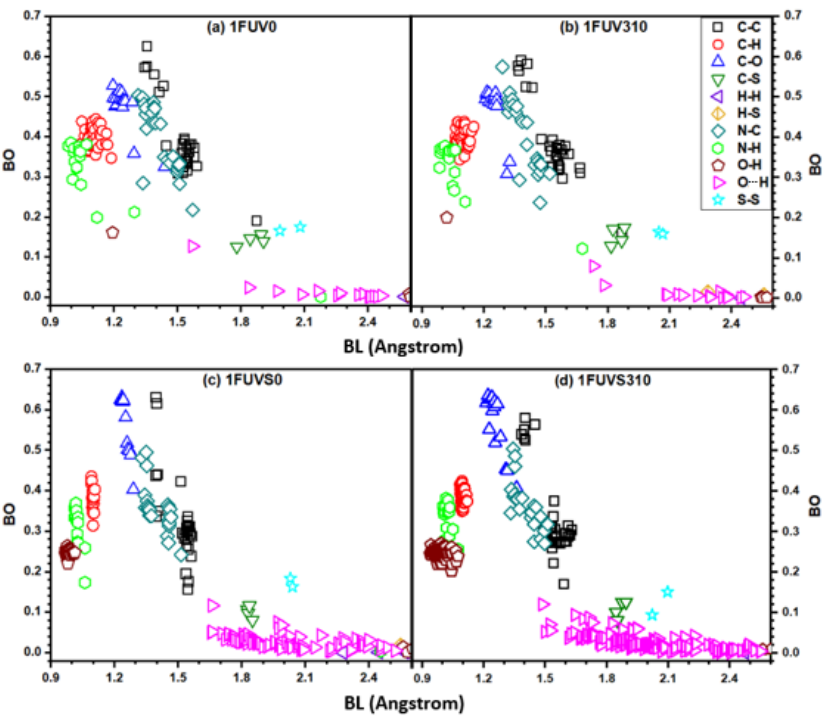
Figure 5. BO versus BL plot for dry and solvated 1FUV at 0 K and 310 K.